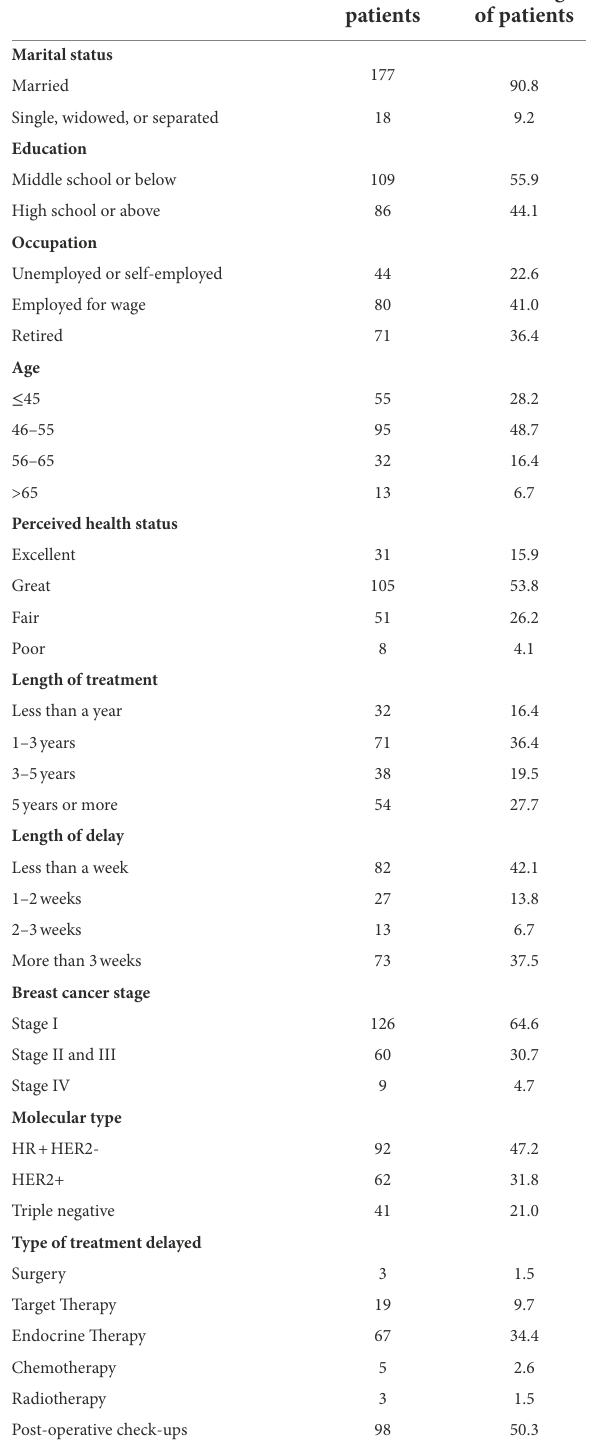
Number of Percentage patients of